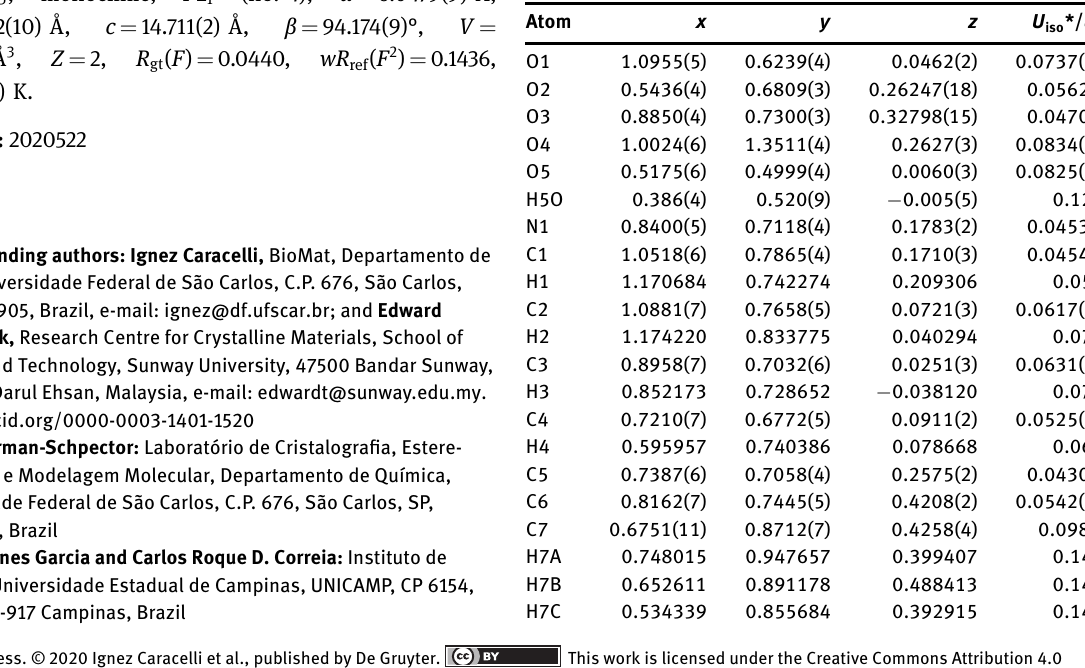
Table 2: Fractional atomic coordinates and isotropic or equivalent isotropic displacement parameters (Å 2